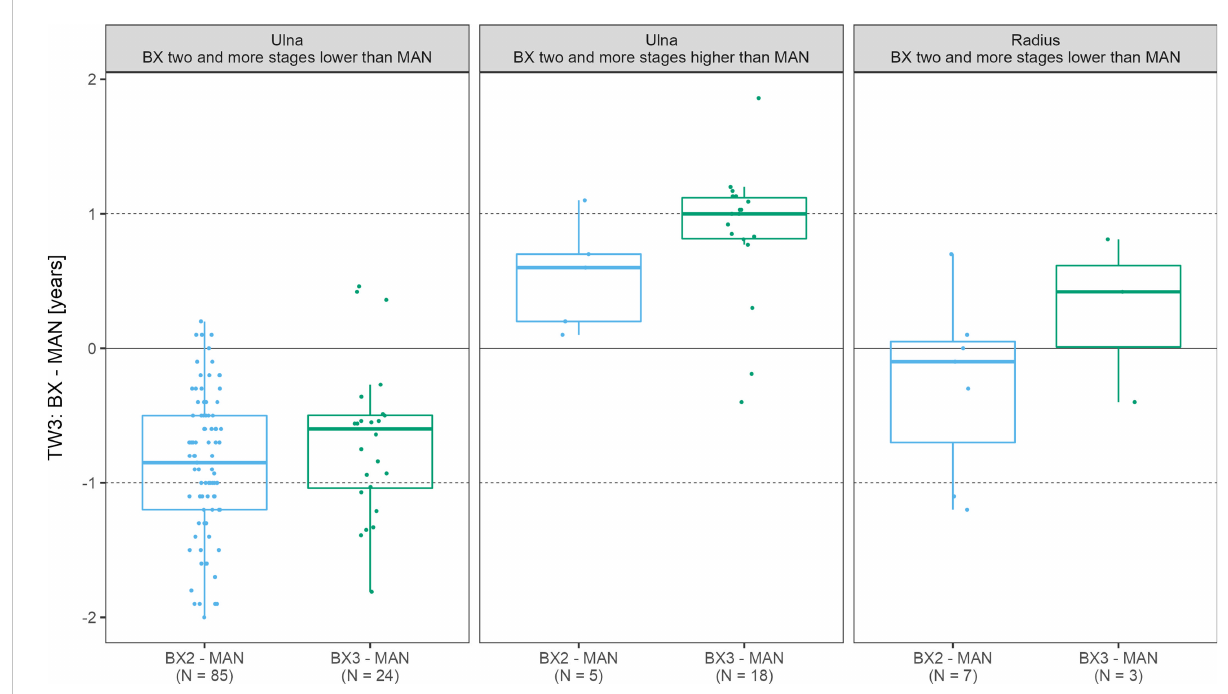
FIGURE 4 The boxplots depict the distribution and mean differences in years between automated and manual fi nal bone age in scans where bone stage assigned to radius/ulna exceeded 2 stages. TW3, bone age assessment according to Tanner-Whitehouse 3 method; GP, bone age assessment according to Greulich-Pyle method; BX2, BoneXpert version 2.4.5.1.; BX3, BoneXpert version 3.0.3.; MAN, manual bone age